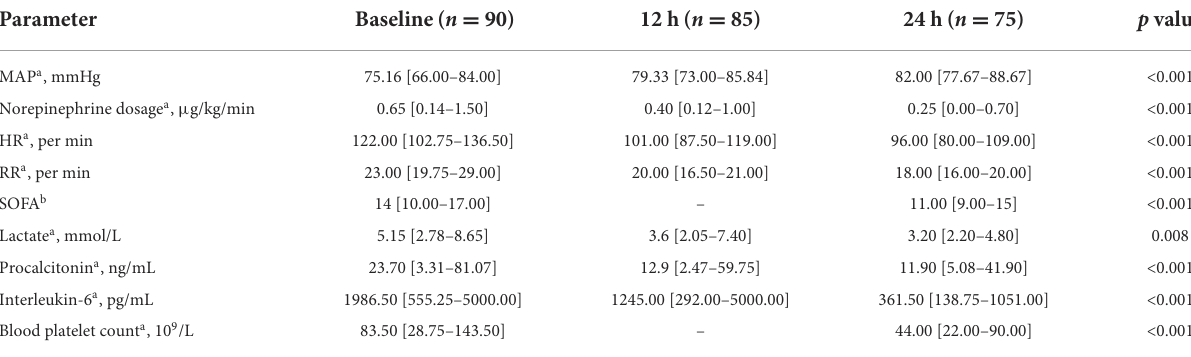
TABLE 3 Hemodynamic and inflammatory biomarkers, metabolic changes, and blood platelet count during oXiris-CHFA treatment.